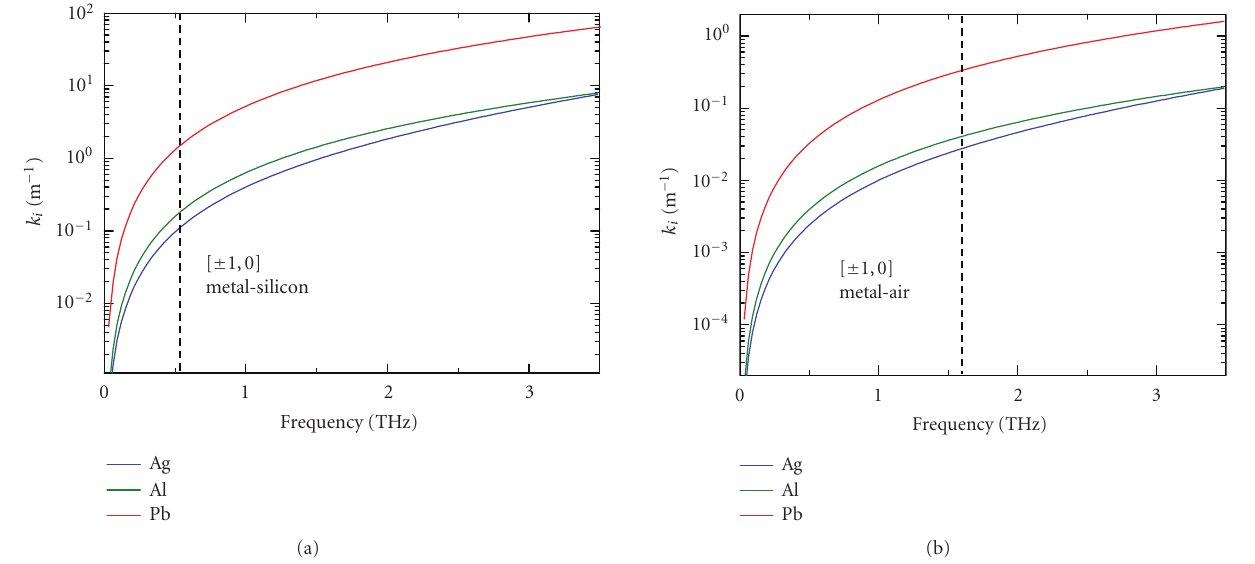
Figure 6: Frequency-dependent imaginary propagation vectors of SPs for Ag, Al, and Pb along (a) metal-Si interface and (b) metal-air interfaces.